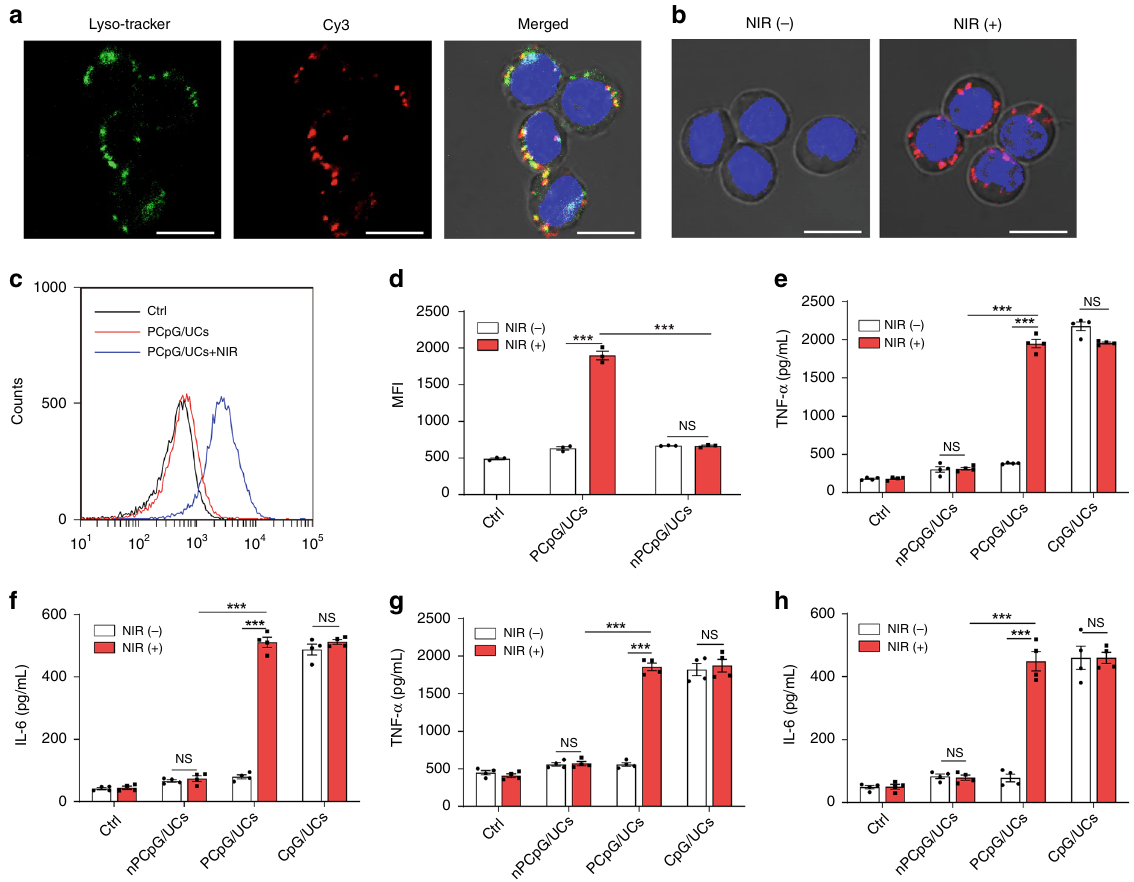
Fig. 3 NIR light triggered activation of PCpG in vitro. a Colocalization images of RAW264.7 cells pretreated with Cy3-labeled PCpG/UCs and further stained with Lyso-Tracker Green. Scale bar, 10 μ m. b Confocal fl uorescence images of RAW264.7 cells treated with FRET pair-labeled PCpG/UCs with and without subsequent NIR light irradiation (980 nm, 1.2 W/cm 2 ). Nucleus (blue) and DNA (red) in confocal images. c , d Flow cytometric analysis ( c ) and quanti fi cation ( d ) of the cells from ( b ). The data are presented as the mean ± s.e.m. ( n = 4). Comparisons were made using Student ’ s t -test, ***P < 0.001. e – h Cytokine secretion by RAW264.7 cells upon indicated treatments. The concentration of cytokines in the culture medium was measured immediately ( e , f ) and subsequently at 24 h ( g , h ) after the initial 8 h treatment. The data are presented as the mean ± s.e.m. ( n = 4). NS not signi fi cant, ***P < 0.001 (one-way ANOVA). Source data are provided as a Source Data fi